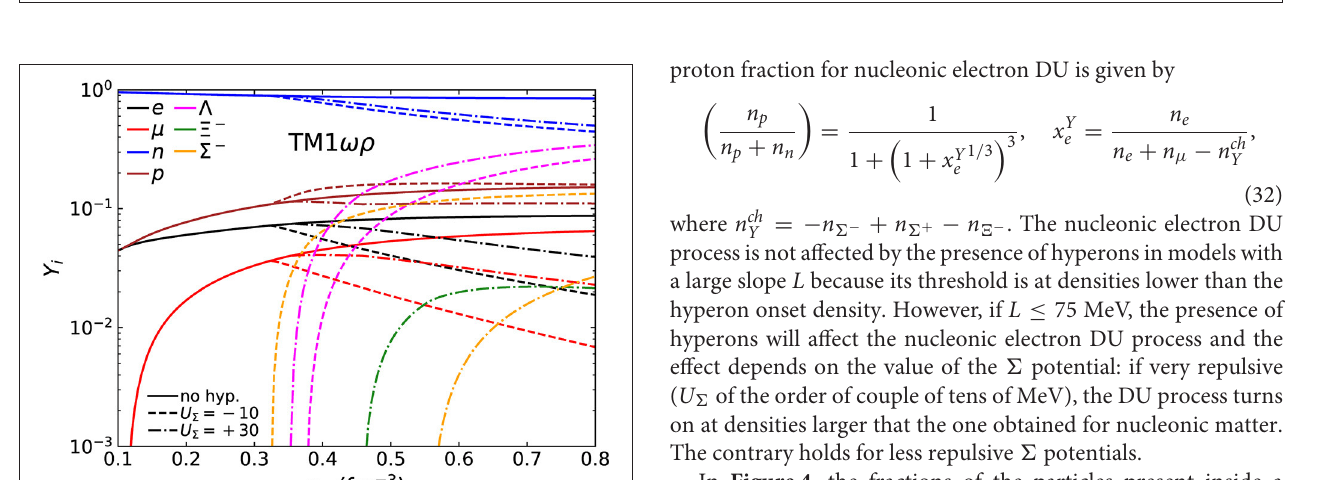
FIGURE 3 | (Right) Onset density of the different hyperons ( 3 , 6 − , and 4 − ) (red, yellow, and green lines), and of the DU process (blue lines), and NS central density at the maximum mass (black lines) for the TM1 ωρ family and three different values of the 6 potential at saturation ( the symmetry energy L . (Left) The NS masses corresponding to the different densities plotted in the right panel. The DU onset density in nucleonic matter and corresponding star mass are also shown with blue dots. All other curves were obtained with models including hyperons.